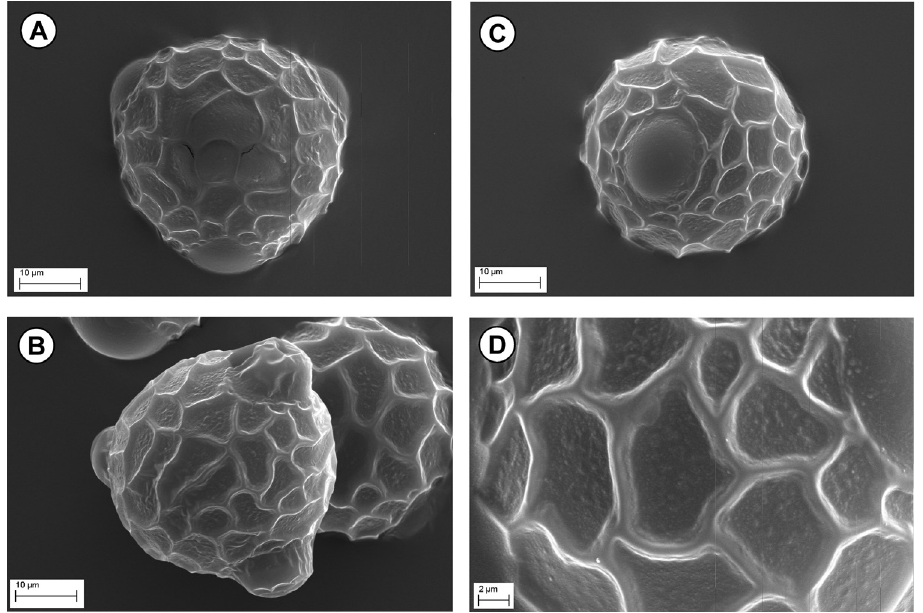
Figure 6. SEM micrographs of pollen grains of Bituminaria antiatlantica from Mount Tachilla. A–B Polar view (× 1600) C Equatorial view (× 1600) D Detail of pollen surfaces (×